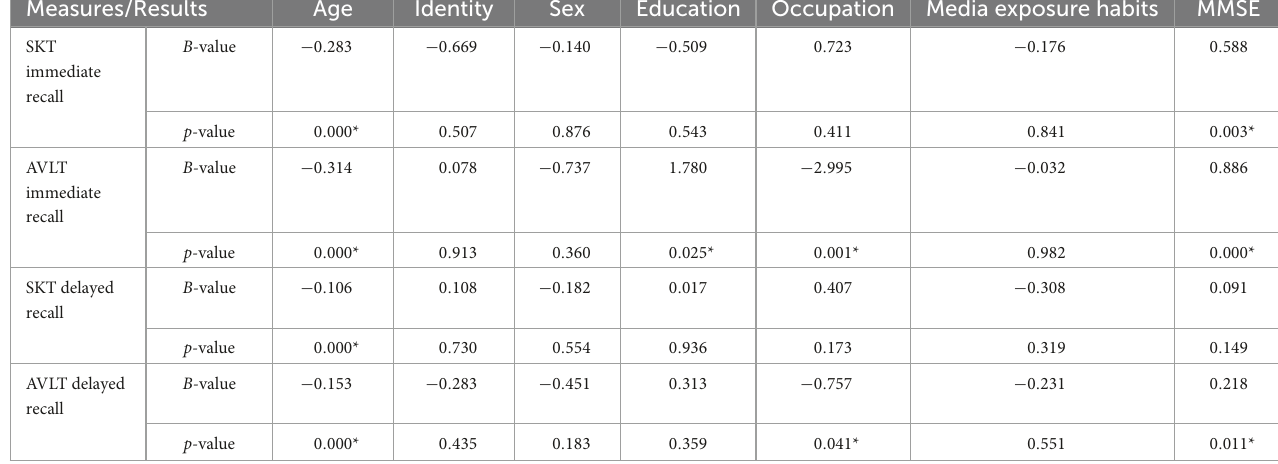
TABLE 5 Analysis of test deviation between SMOT and AVLT.